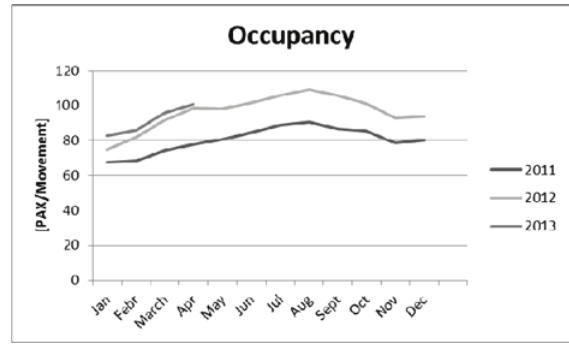
fig. 6. Average occupancy (Source: own edition based on Hungaro Control